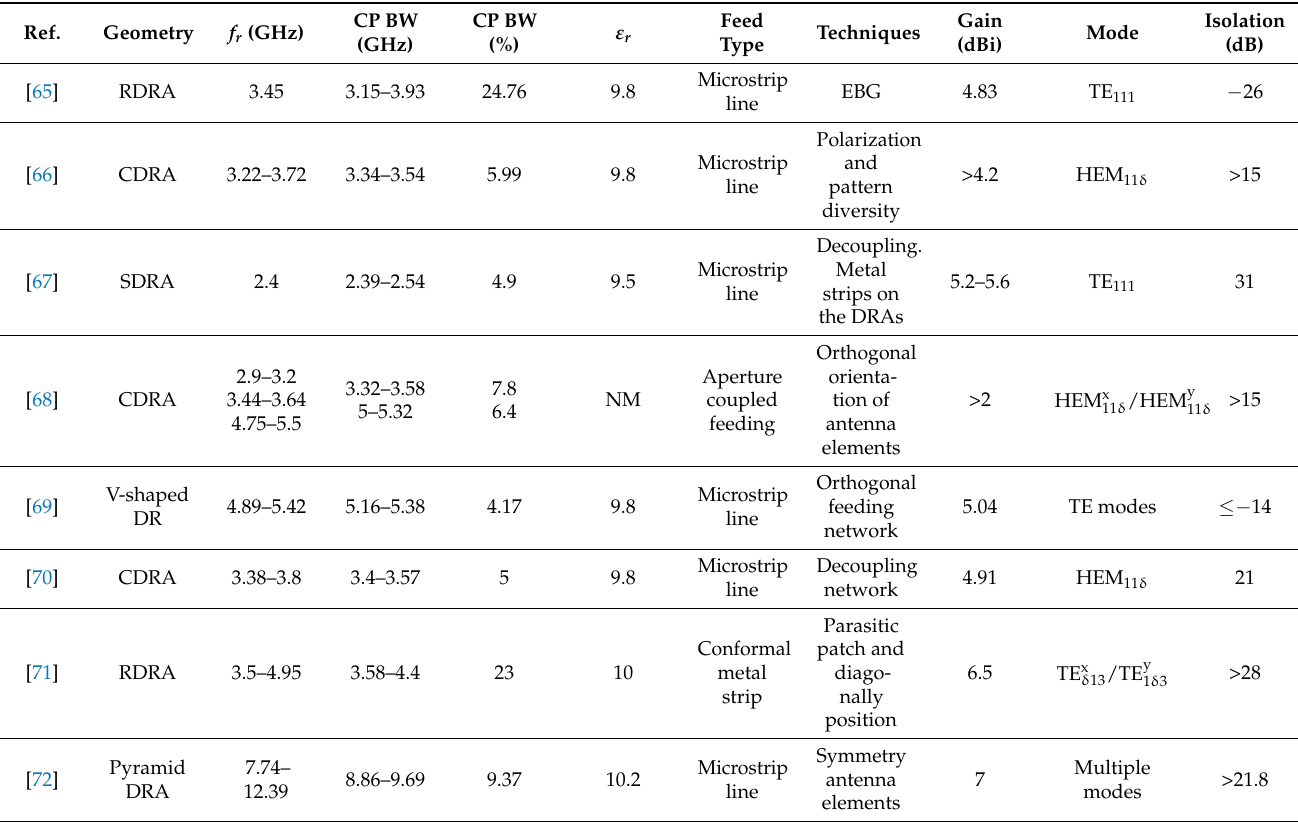
Table 5. Comparison between various MIMO circularly polarized